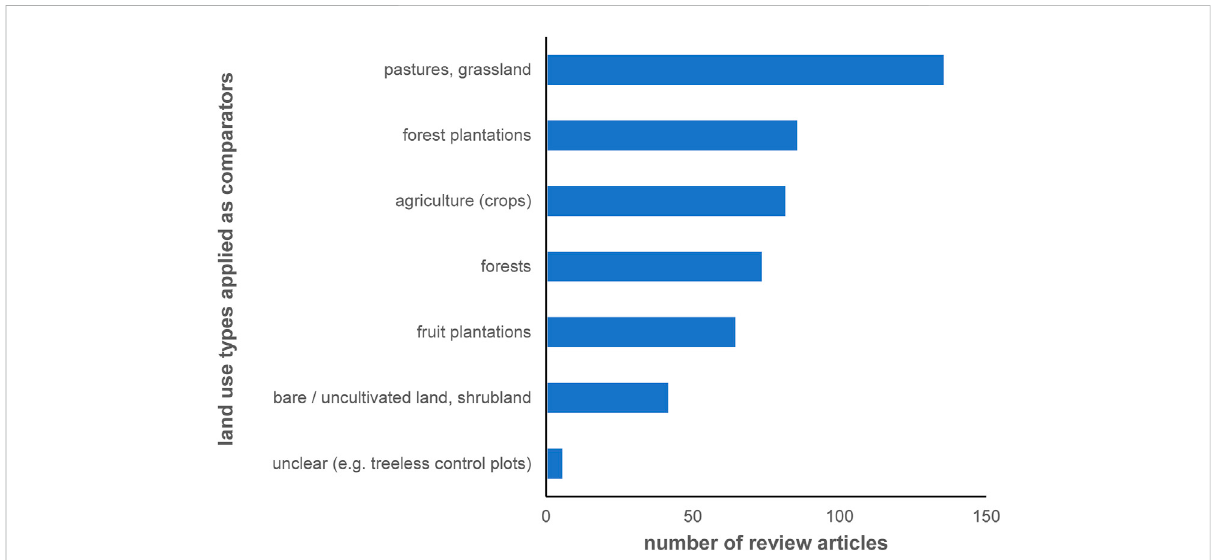
FIGURE 9 Landusetypesappliedascomparatorsinreviewarticles(n=64reviewarticles,somearticlesconsidermorethanonecomparator).Forestsand agriculture (crop monoculture) were most often applied as a